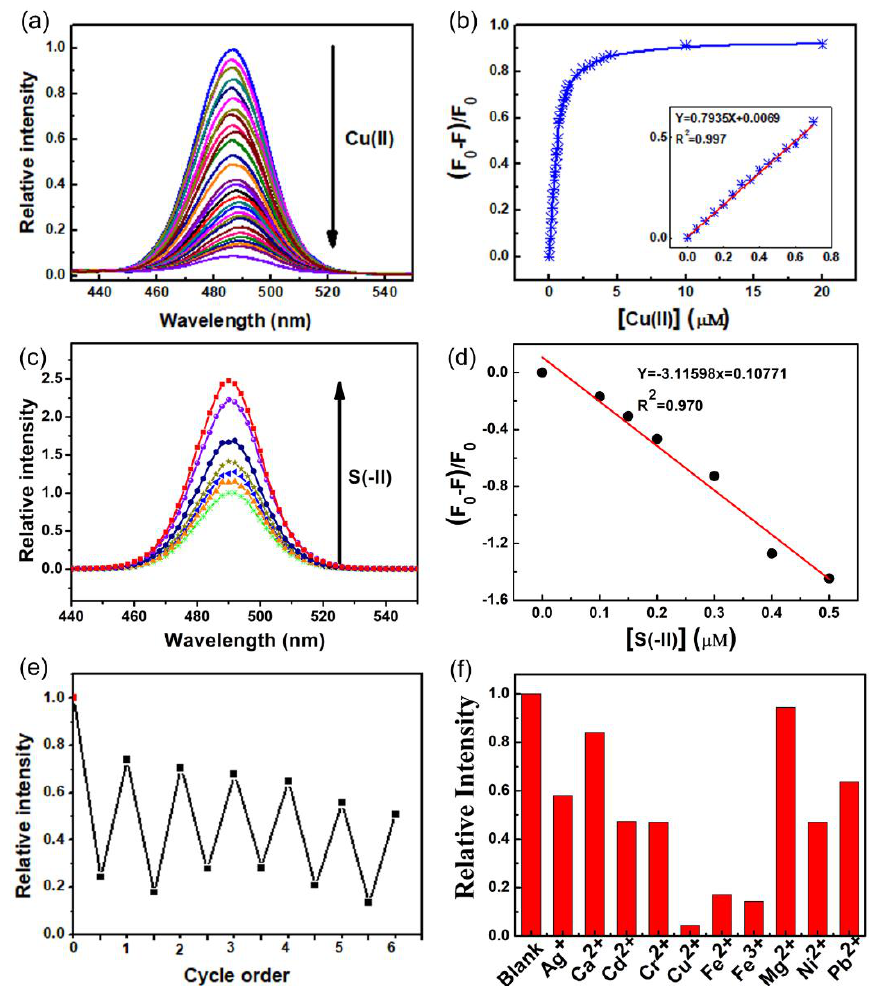
Figure 6. ( a ) The fluorescence intensity of HFNs in the presence of Cu(II) (aqueous solution); ( b ) the relationship between F 0 - F / F 0 of HFNs in the presence of Cu(II); ( c ) the fluorescence intensity of HFNs@Cu(II) in the presence of S(-II), 2 × 10 10 particles mL −1 of nanospheres at most (2-(N-morpholino) ethanesulfonic acid (MES) buffer pH = 5.5); ( d ) the relationship between F 0 - F / F 0 of HFNs @ Cu(II) in the presence of Cu(II); ( e ) the cycle order of S(-II) (MES buffer pH = 5.5); ( f ) the fluorescence intensity decrease of HFNs in the presence of various metal ions (10 µM of metal ions in aqueous solution and 2 × 10 10 particles mL −1 of HFNs (HN5 with 8 wt.% 5-AF) at most). The synchronous fluorescence spectrum spectra were recorded at 25 °C.